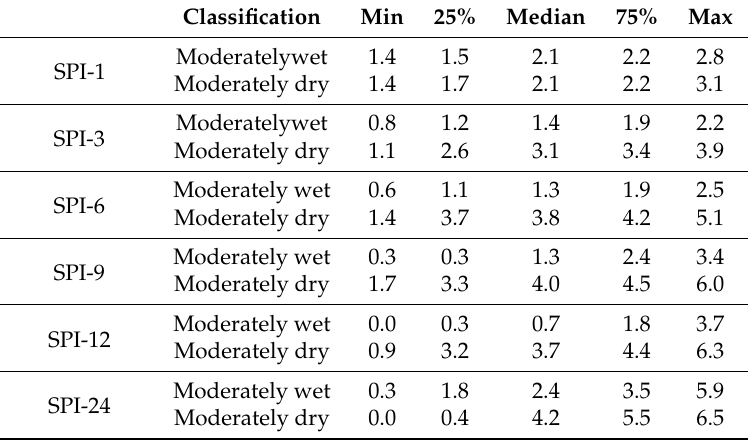
Figure 5. SPI for multiple timescales under RCP8.5 scenario (2021–2050) for Danang station. Table 5. Percentages of drought and wet events under considered multiple timescales under RCP4.5 scenario over basin during 2021–2050 (%).